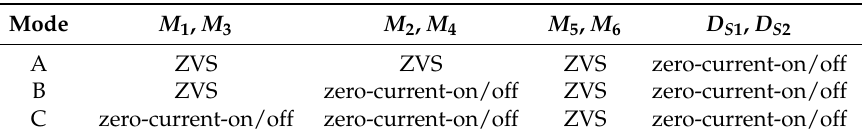
Table 3. Switching behavior in different